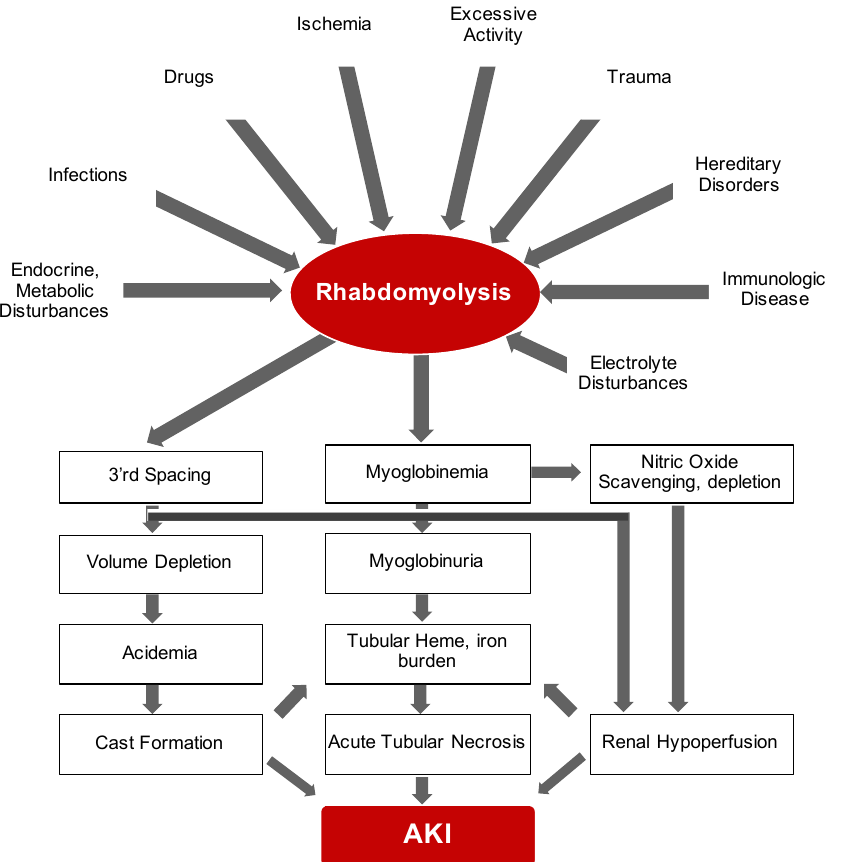
Figure 1. Simplified schematic demonstrates potential culprits and pathogenesis of rhabdomyolysis leading to AKI.